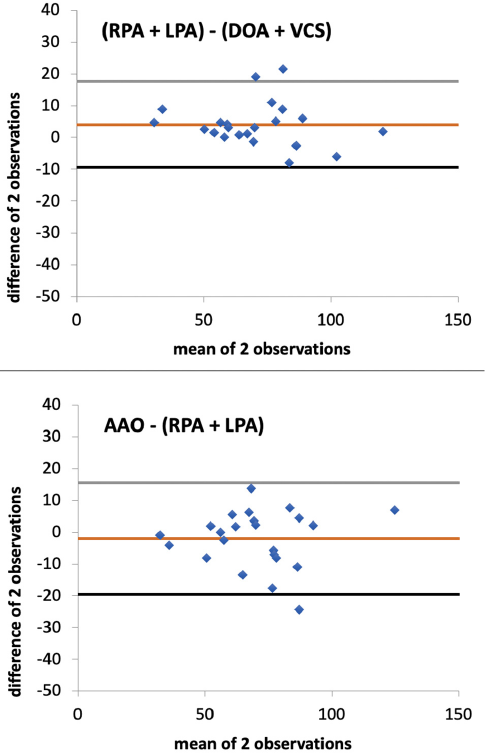
Figure 4. Bland and Altman analyses of SV (RPA+LPA) against SV (DOA+VCS) and SV AAO . LoA are in grey and black. Bias is in orange. Results are in stroke volume (mL/beat). AAO: ascending aorta, DAO: descending aorta, LPA: left pulmonary artery, RPA: right pulmonary artery, SVC: superior vena Table 5. Fifteen paired comparisons of the six different MRI methods.